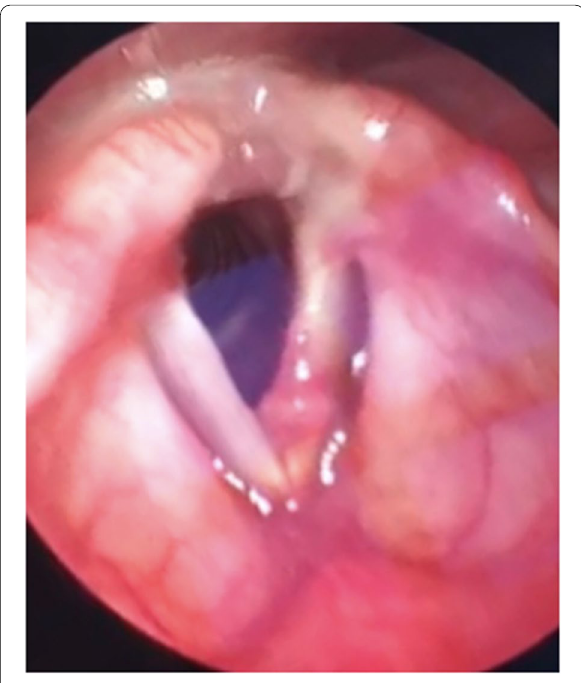
Fig. 1 Indirect laryngoscopy view showing polypoid mass at anterior two thirds of the left membranous vocal fold